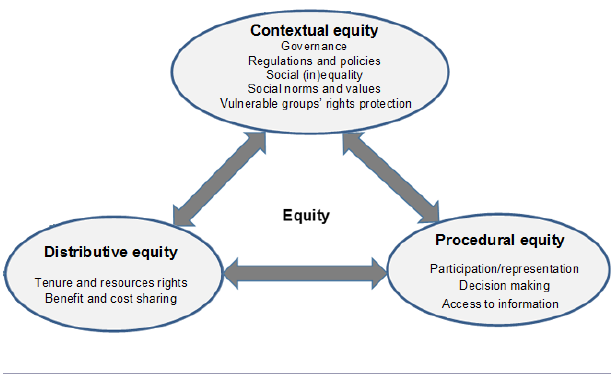
Fig. 1 . The three interdependent dimensions of equity and their constitutive